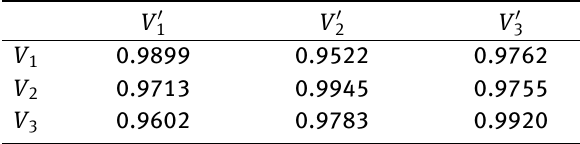
Table 1: The similarity of